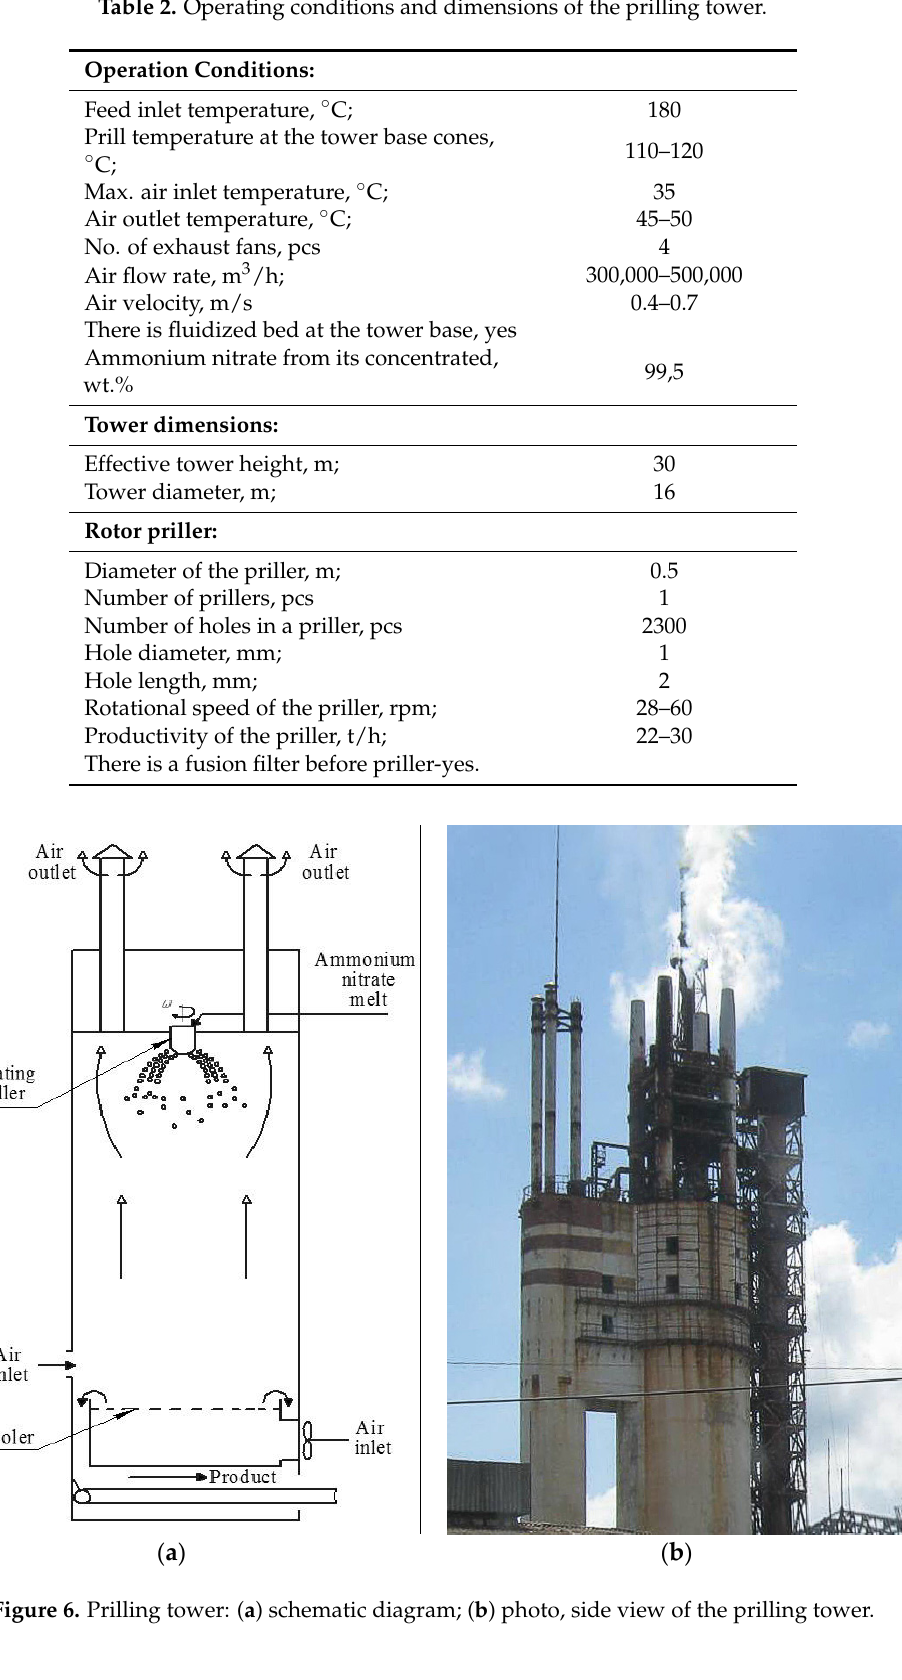
Table 2. Operating conditions and dimensions of the prilling tower.